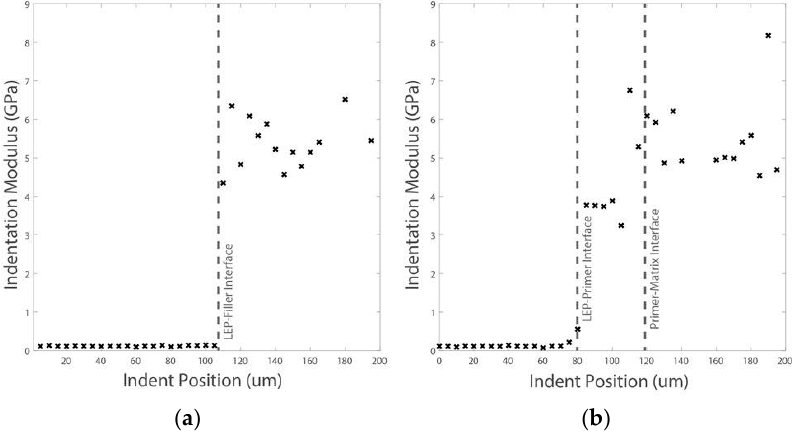
Figure 27. Series of indents across leading edge protection coating configuration with two distinctive interfaces. ( a ) LEP–filler interface and ( b ) LEP–primer–filler interface.